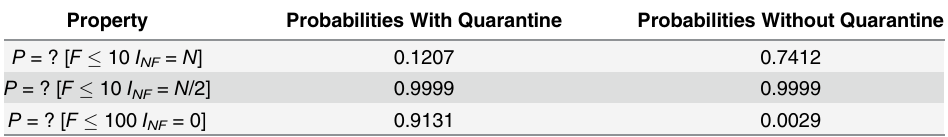
Table 2. Results with and without Quarantine for sample size